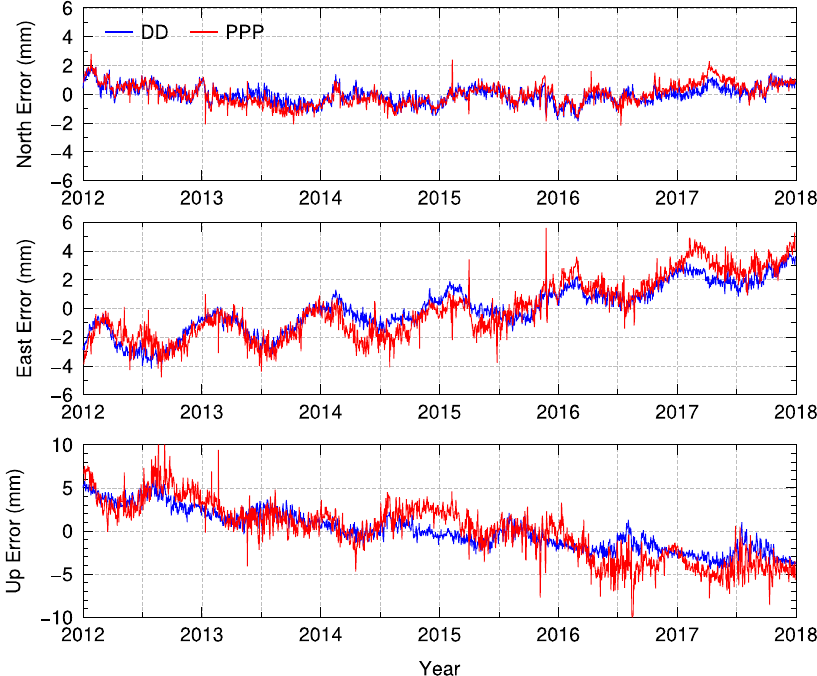
Figure 13. Time series comparison between PPP solutions and DD baseline resolutions.